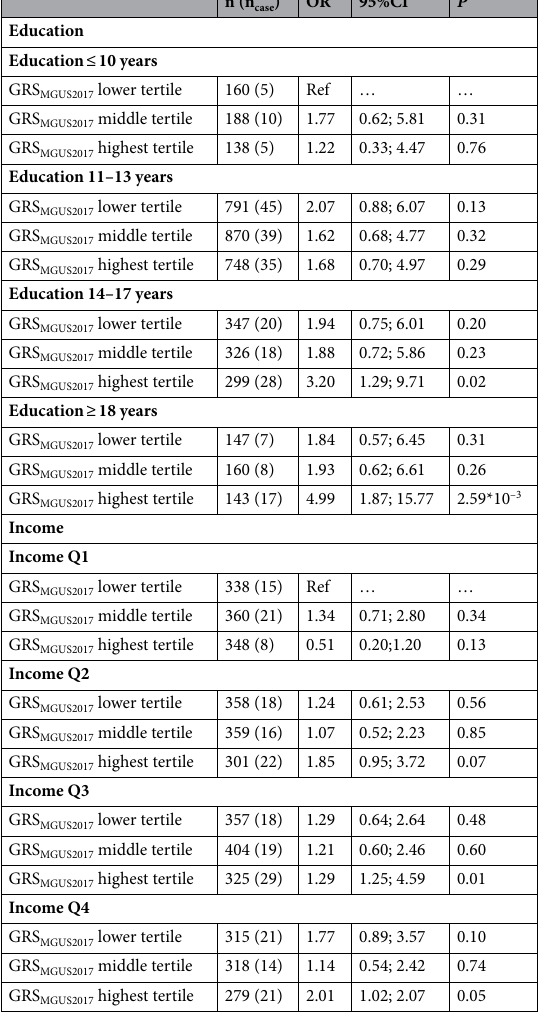
Table 4. Sex-and age adjusted odds ratios (OR) and 95% confidence intervals (95% CI) for the single reference joint effects of the genetic effect (GRS MGUS2017 ) and SEP indicators on MGUS status calculated separately for income and education with the group of being in the low genetic risk score tertile and the lowest SEP category as reference.